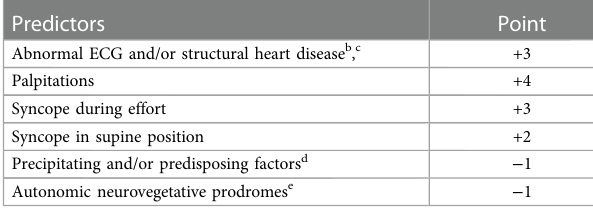
TABLE 1 The evaluation of guidelines in syncope study (EGSYS) scores a